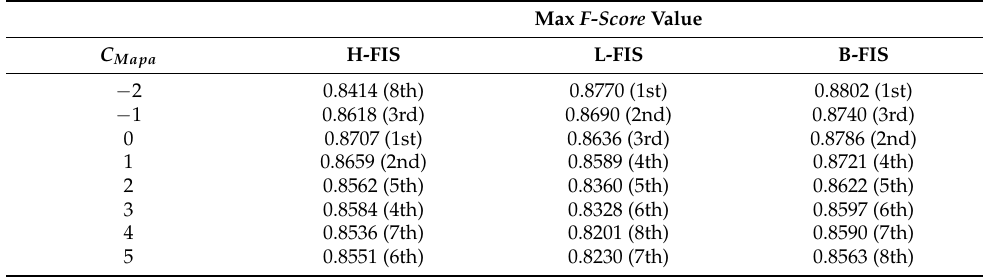
Table 10. Ranked values of F-Score for C Map for the Ecoli